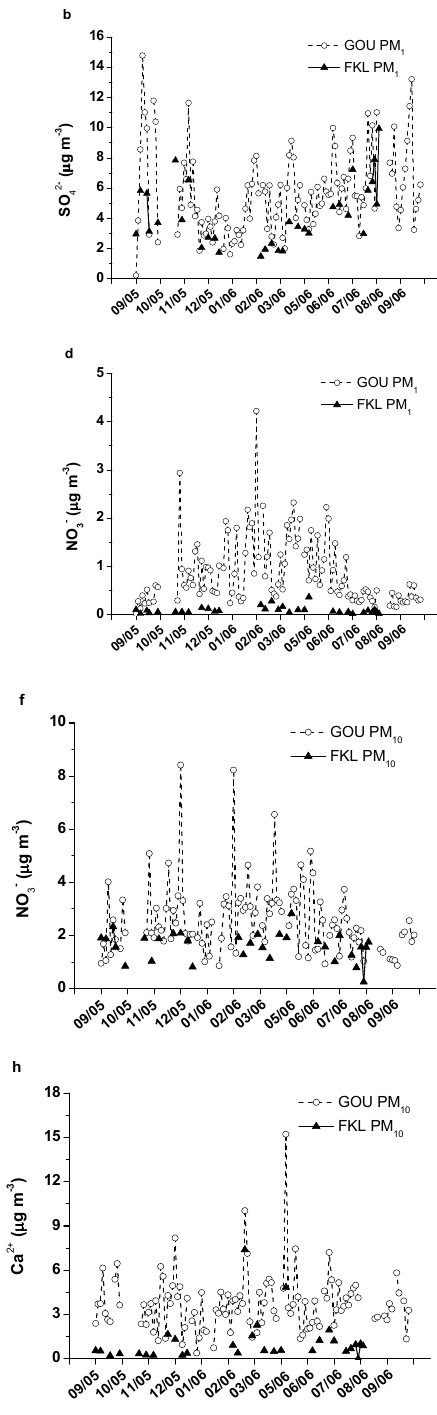
, NO − , Ca 2 + , C 2 O 2 − and K + in PM 1 4 3 4